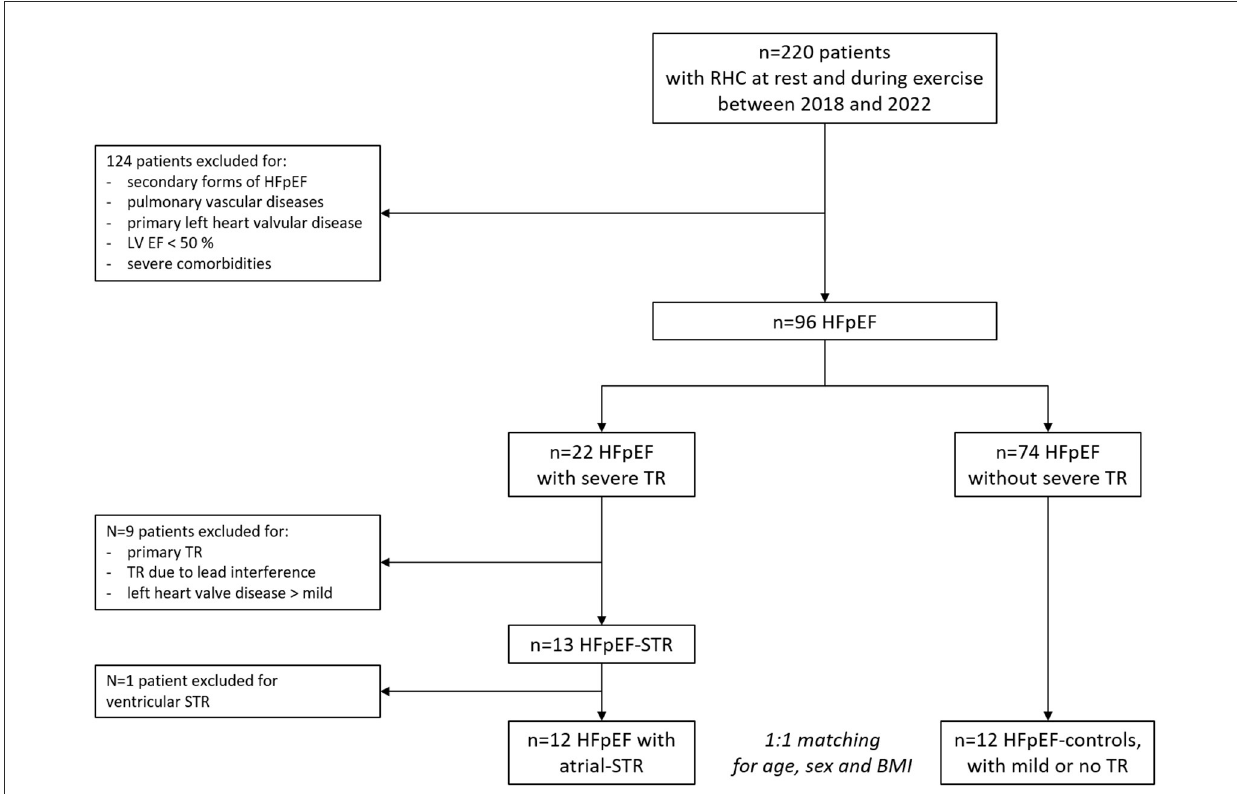
FIGURE1 Patients’ selection flow-chart. BMI, body mass index; HFpEF, heart failure with preserved ejection fraction; LV EF, left ventricular ejection fraction; RHC, right heart catheterization; STR, secondary tricuspid regurgitation; TR, tricuspid regurgitation.